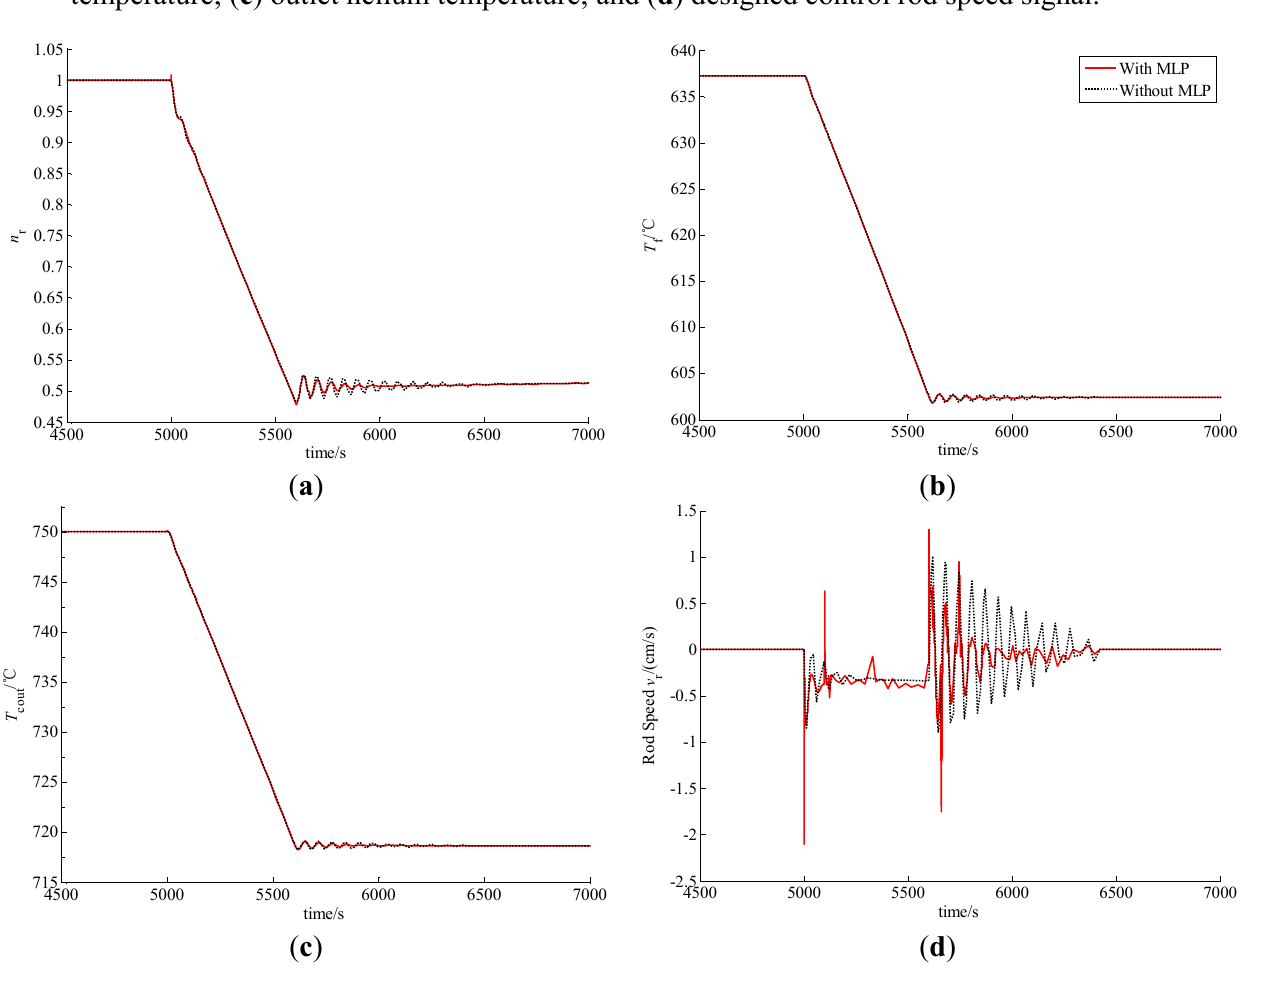
Figure 5. Simulation results in Case A: ( a ) relative nuclear power; ( b ) average fuel temperature; ( c ) outlet helium temperature; and ( d ) designed control rod speed